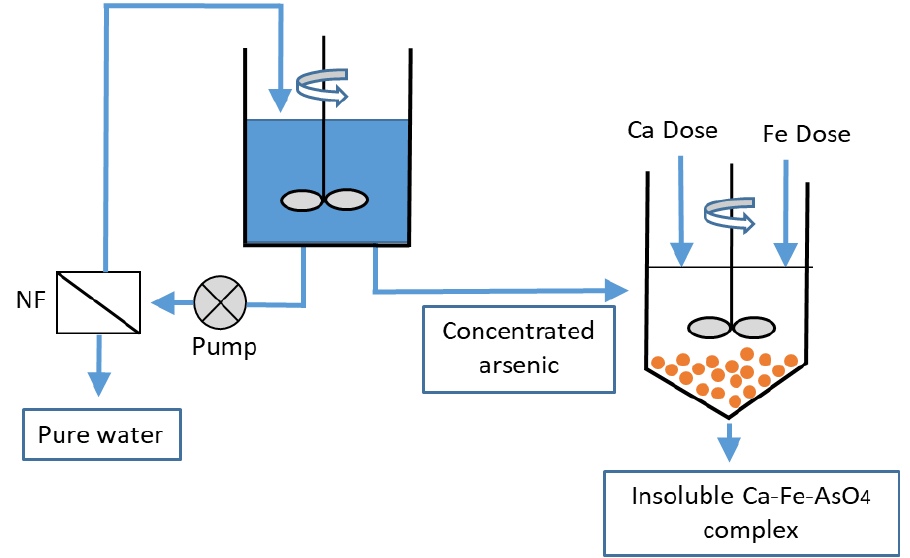
Figure 9. A nanofiltration–coagulation integrated system for separation and stabilization of arsenic from groundwater (adapted from [84]).